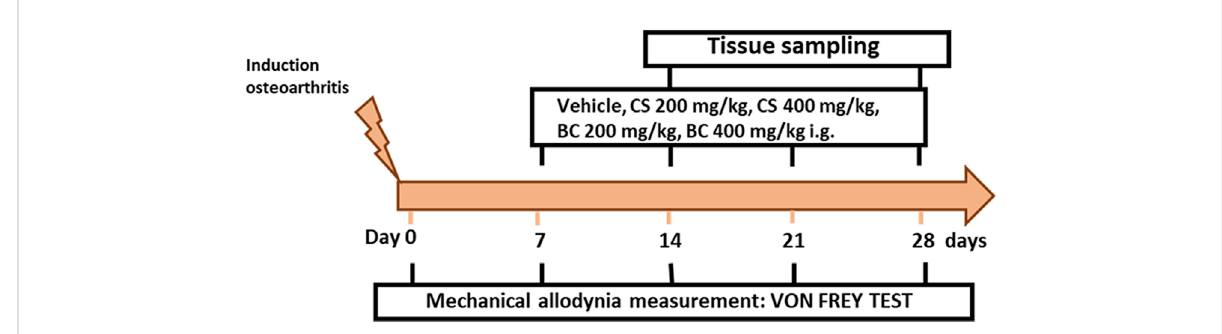
FIGURE 1 Timeline oftheexperimentalprocedureofosteoarthritisinductionand relatedbehavioralcharacterizationinthepresence ofvehicle,CS,or BC treatment. On day 0, after mechanical allodynia basal-level measurements, mice received a single intra-articular injection of vehicle or monoiodoacetate(1 mg/mouse).Chondroitinsulfate(CS)orbiotechnological(BC)andsaline(vehicle)wereadministereddailyforthreeconsecutive weeks starting from day 7 after MIA